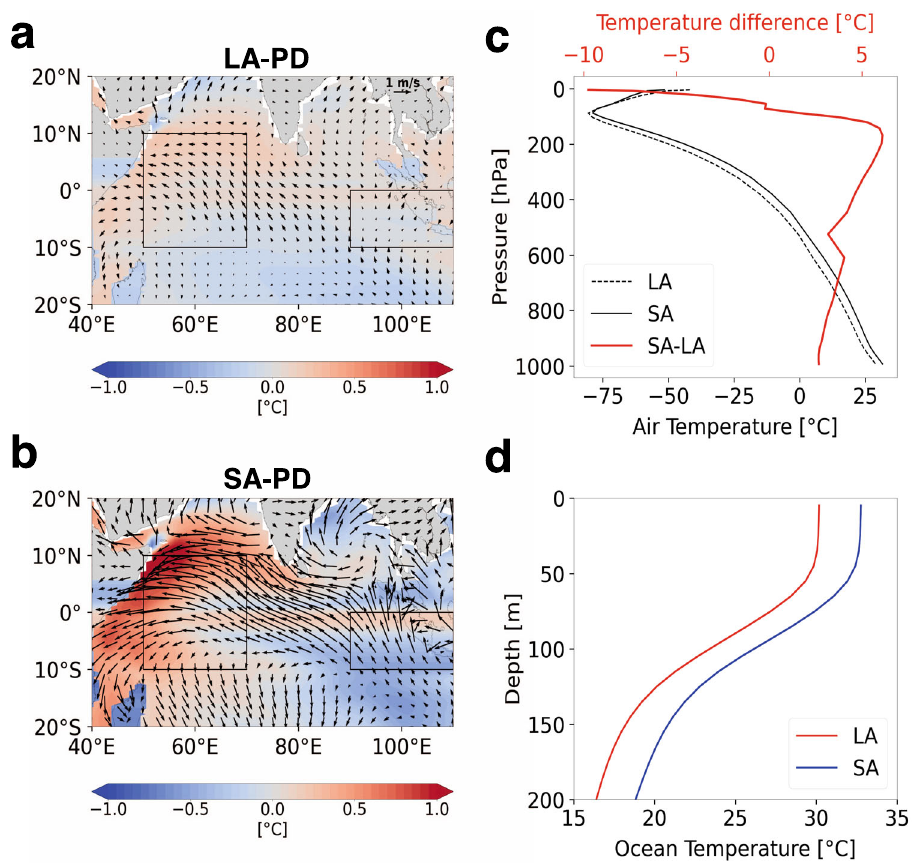
Fig. 4 Indian Ocean climate conditions for large and small IOD amplitude periods. Difference in boreal-summer mean SST and surface winds a between 30-year LA period and PD simulation, and b 30-year SA period and PD simulation. Area-averaged SST over Indian Ocean domain has been removed in each fi gure. Units for temperature are °C, and wind vectors are represented in the upper right corner in a . c Boreal-summer mean atmospheric vertical temperature pro fi le averaged over tropical Indian Ocean (60° – 100°E, 5°S – 5°N) for LA (dotted line) and SA (solid line) periods, and their difference (red line). d Boreal-summer mean vertical ocean temperature pro fi le from the surface to a depth of 200 m, averaged over the tropical Indian Ocean (40 – 100°E, 5°S – 5°N) for LA (red line) and SA (blue line) periods.